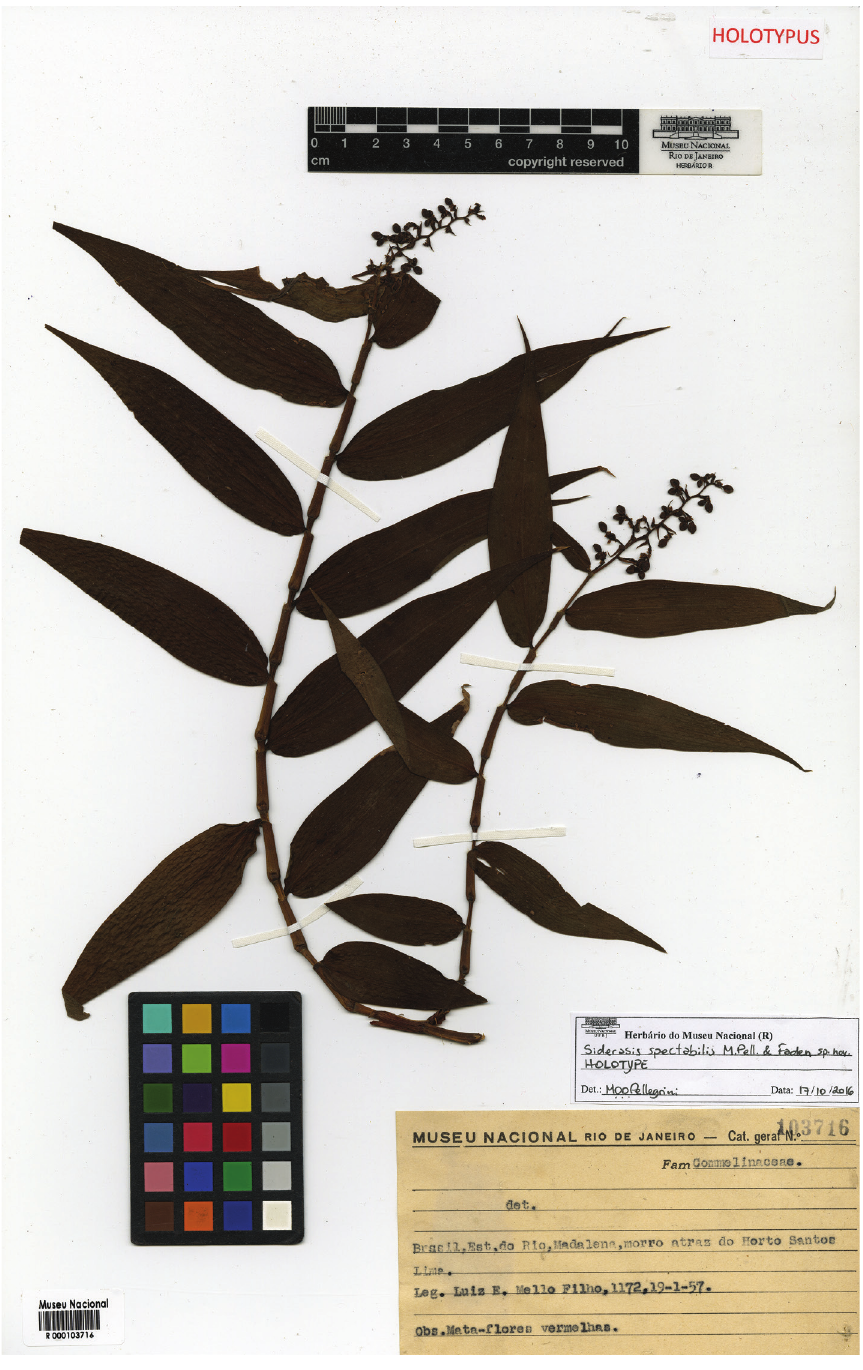
Figure 10. Holotype of Siderasis spectabilis M.Pell. & Faden. Image courtesy of the Museu Nacional, Rio de Janeiro,